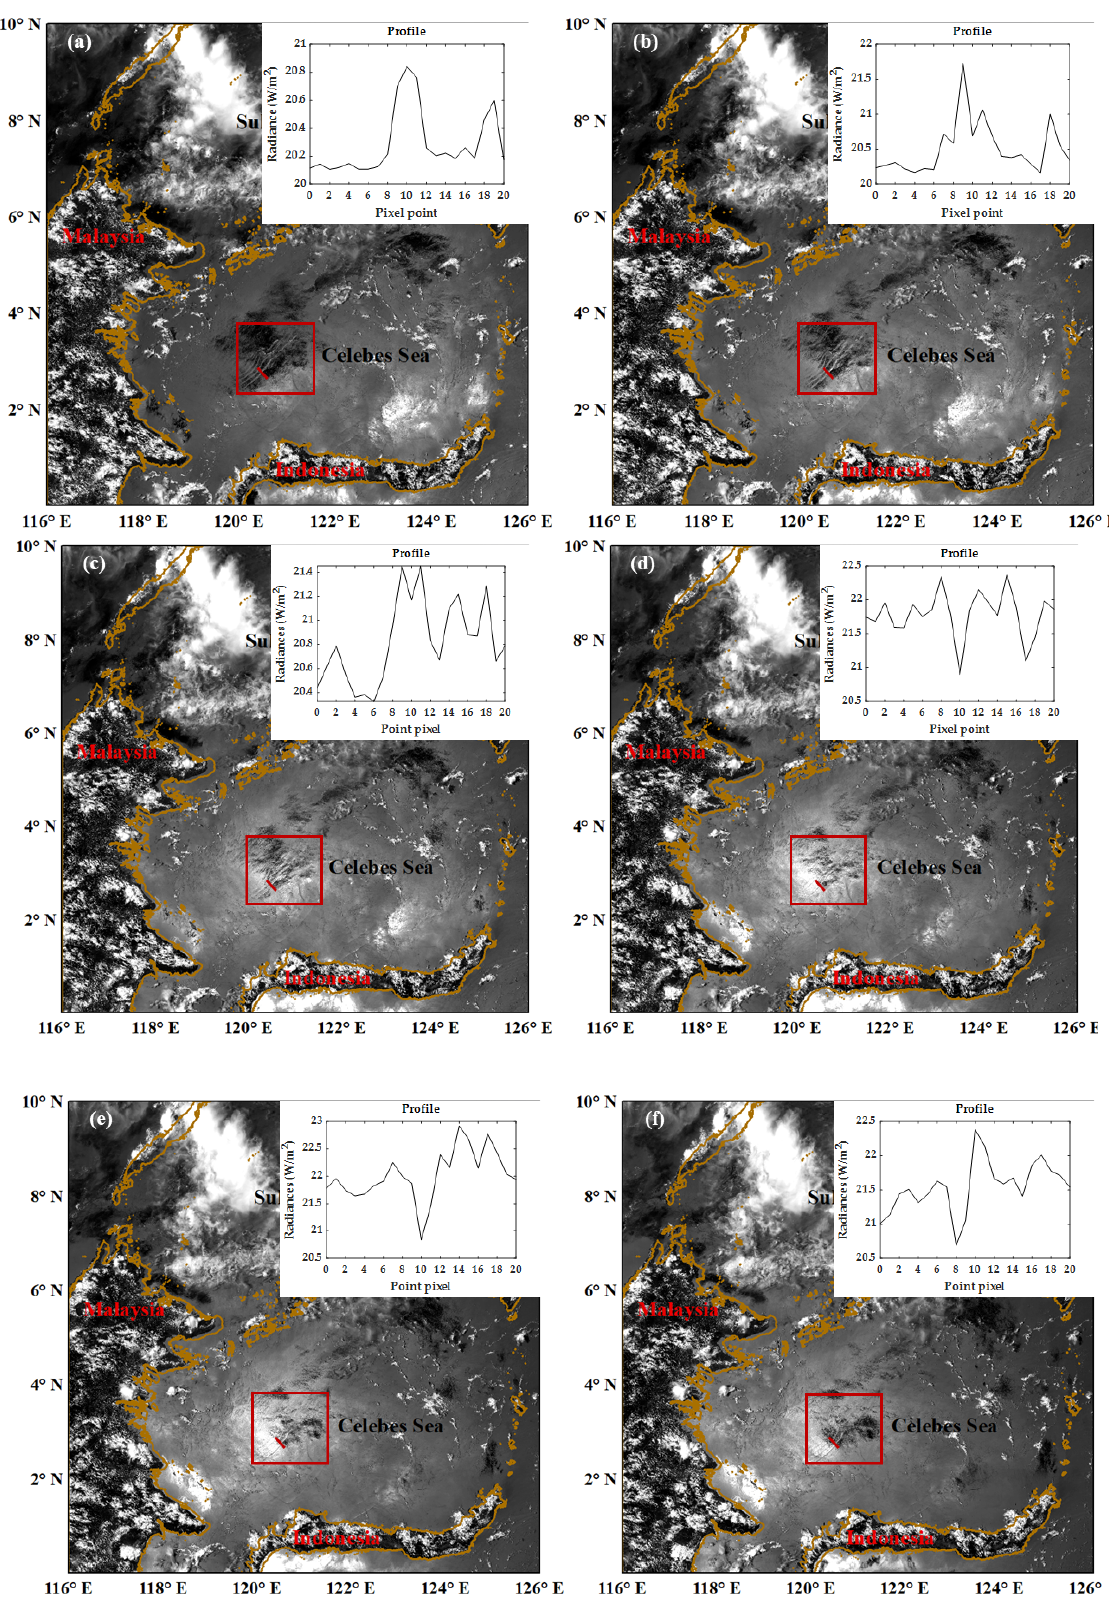
Figure 5. Himawari-8 images of the Celebes Sea acquired on 21 September 2020. The internal solitary wave packet is framed by a red box, and the red solid line corresponds to the profile of the crest of the leading wave in the upper part of the right side. ( a – f ) show images with an interval of 10 min between 04:50 UTC and 05:40 UTC.